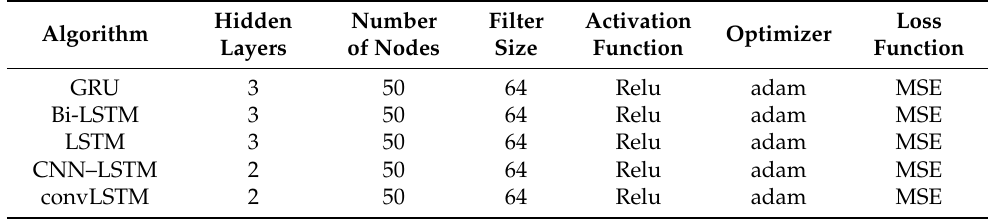
Table 6. Summary of the